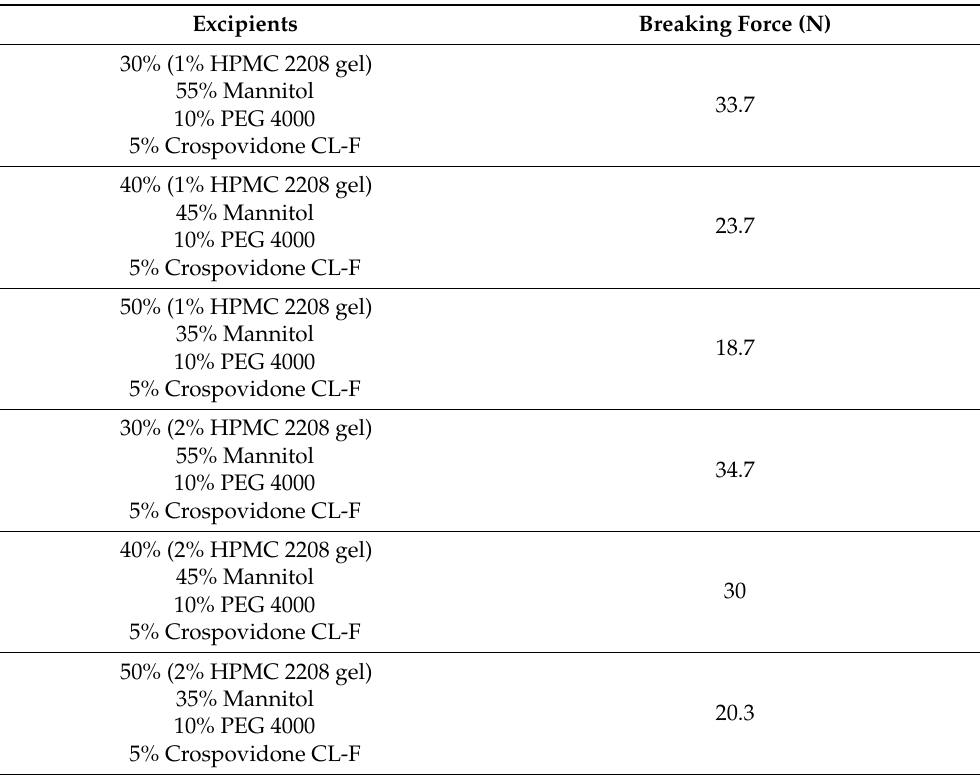
Table 7. Hardness of extrusion printed tablets without the drug, prepared by incorporating different amounts of HPMC hydrogel into the printer ink